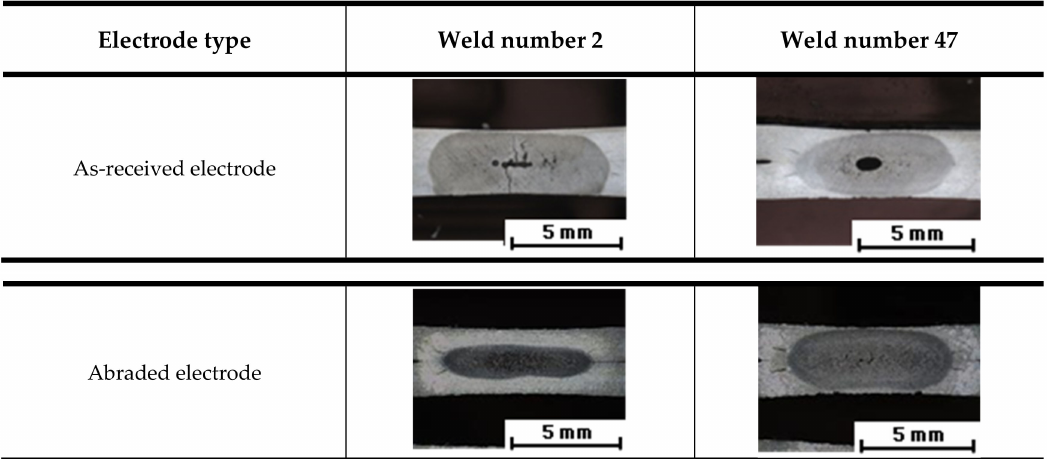
Figure 16. Cross sections of nuggets obtained using the as-received and the abraded electrodes during continuous RSW at electrode force of 600